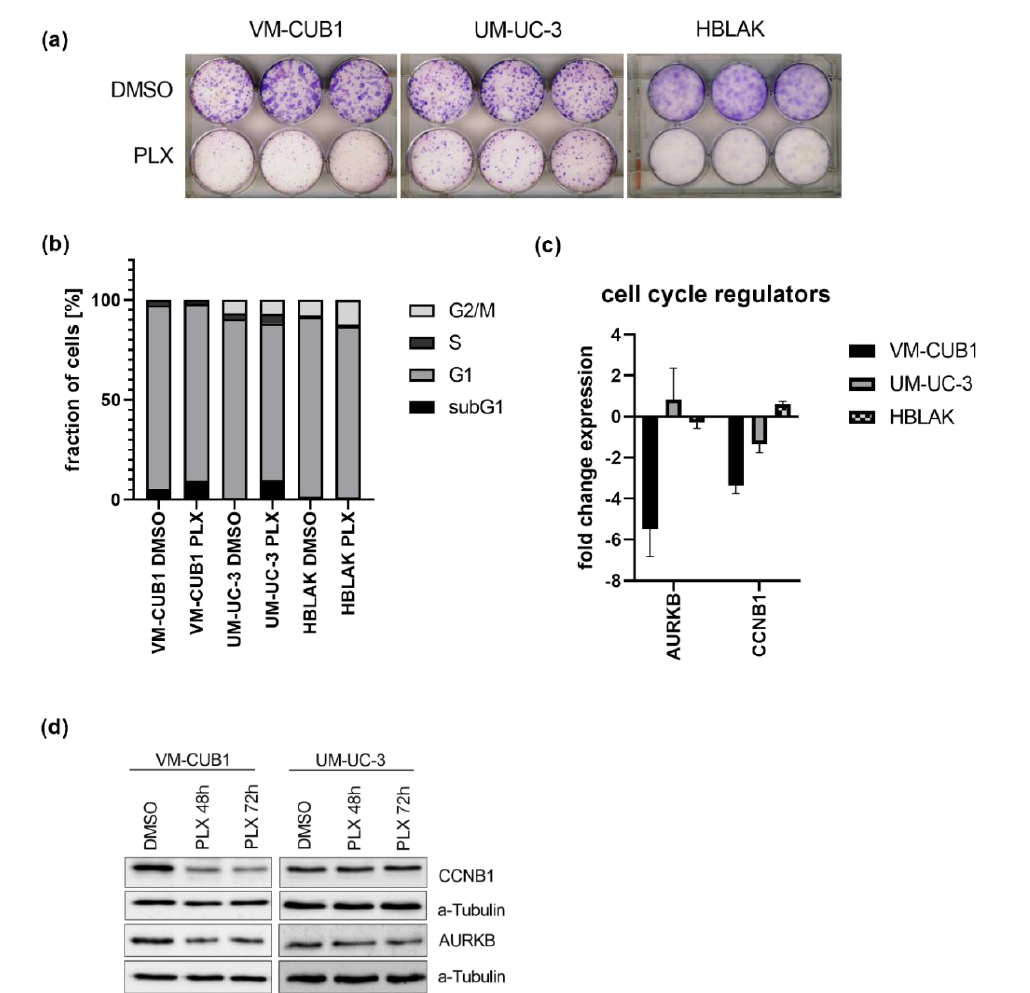
Figure 1. Impact of PLX51107 treatment on proliferation and cell cycle. ( a ) Long-term effects on cell proliferation were investigated by clonogenicity assays. Cells were treated for 72 h with cell line-specific IC 50 doses (VM-CUB1 2 µ M, UM-UC-3 8.8 µ M, HBLAK 0.6 µ M) or DMSO, subsequently highly diluted, and further cultured for 10 days. Cell colonies were stained with Giemsa. ( b ) Cell cycle alterations were monitored by PI (propidium iodide) staining and flow cytometry 72 h after treatment with IC 50 doses of PLX. RNA expression 72 h after treatment with IC 50 doses ( c ) and protein expression 48 h and 72 h after treatment ( d ) of cell cycle regulators CCNB1 and AURKB were determined by qRT-PCR and western blot analysis, respectively. α -Tubulin served as a loading control for western blot analysis. RNA expression of indicated target genes was normalized to the reference gene TBP (TATA-Box Binding Protein) . Expression changes are displayed as fold change relative to the respective DMSO control.